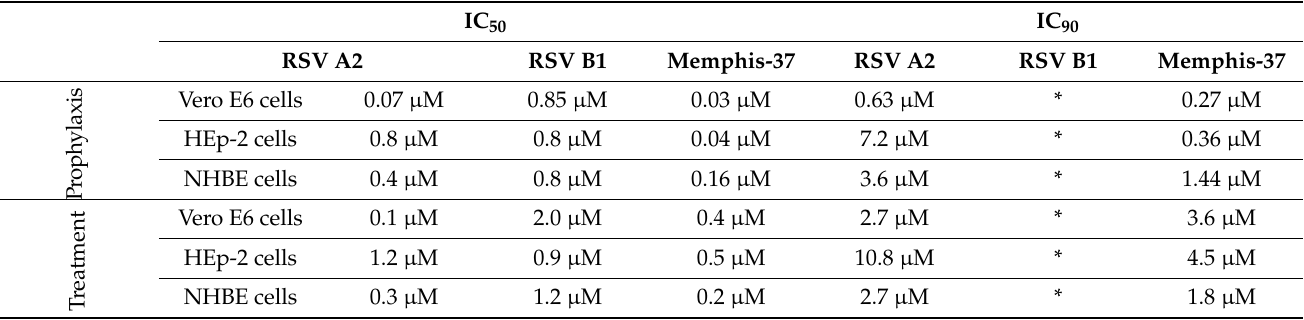
IC 50 and IC 90 values in NHBE cells, Vero E6 cells, and HEp-2 cells after treating with different probenecid concentrations and infecting with RSV A2, RSV B1, or Memphis-37. * = no IC 90 value for the RSV B1 virus as there was not a 90% reduction of virus titers with the concentrations of probenecid